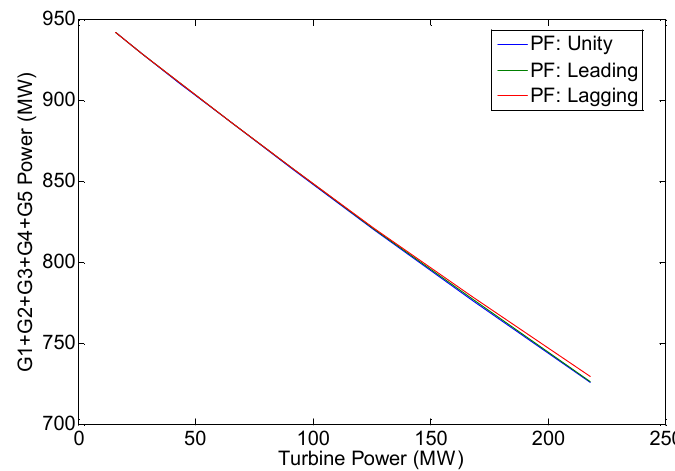
Figure 12. Variation of WPP terminal voltage.